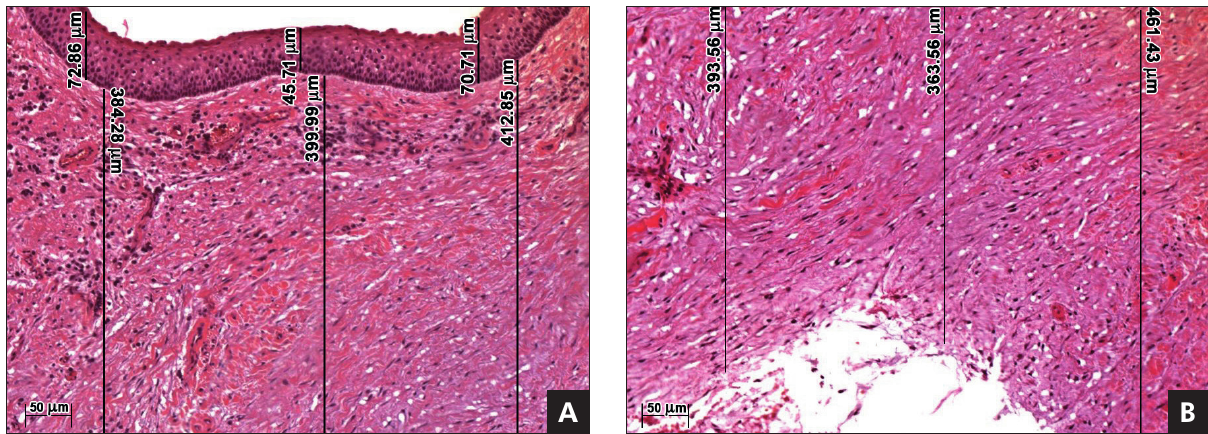
A B Figure 1 - Keratocystic odontogenic tumor specimen before marsupialization. A: The epithelial lining is represented by parake- ratinized stratified squamous epithelium with few layers and a basal palisade layer with cubic or columnar cells and hyperchro- matic nuclei. The epithelial-connective tissue junction is flat. B: Sequential measurements of the fibrous capsule shown in Figure 1A. The fibrous capsule consists of dense, sparsely cellularized, and slightly vascularized connective tissue. The three measure- ments (upper, middle, and lower) of the epithelial lining and fibrous capsule are represented by black lines (hematoxylin-eosin stain, 100 × original magnification).